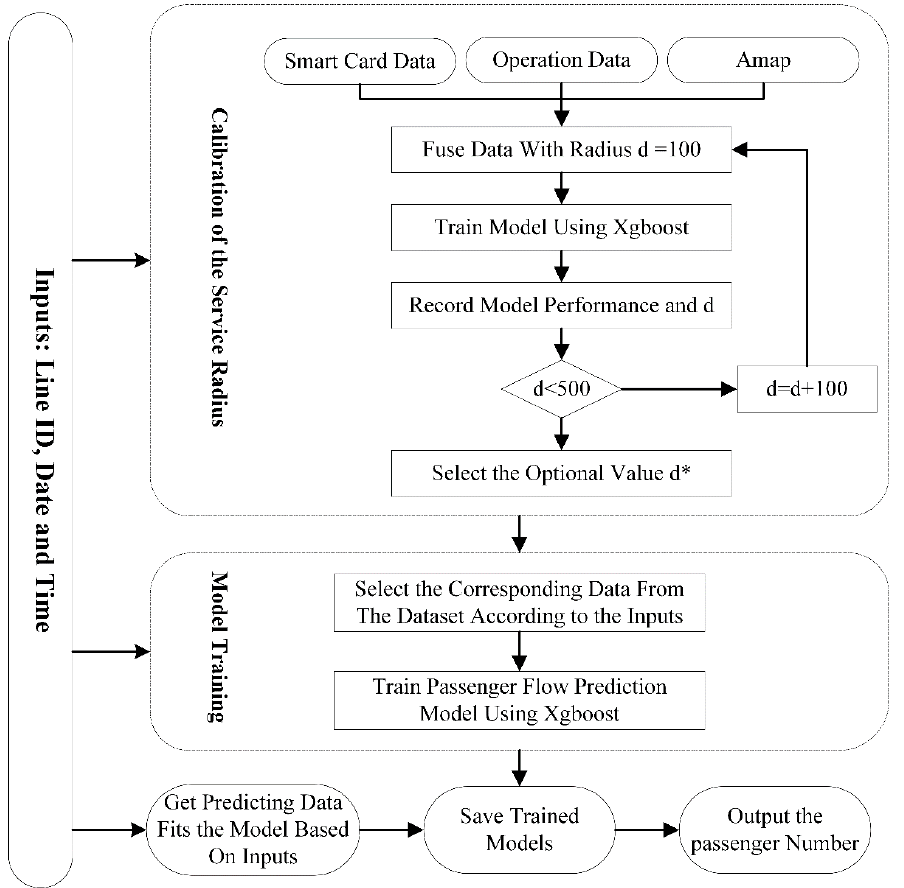
Figure 1. The process and organization of the PFP-XPOI model.